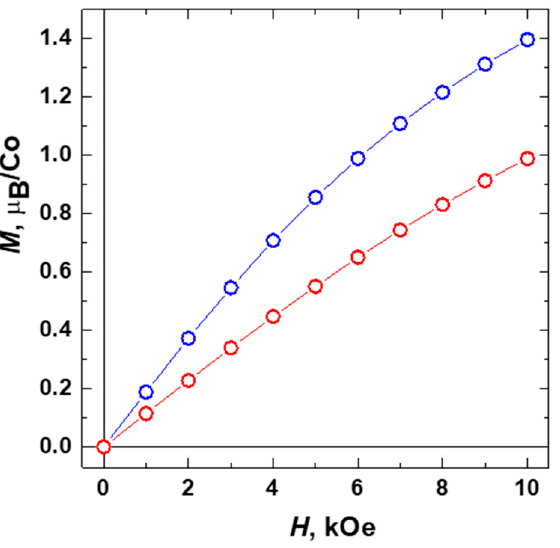
Figure 9. Field-depending magnetization M(H) data for compounds 1 (blue) and 2 (red) taken at T = 1.77 K.